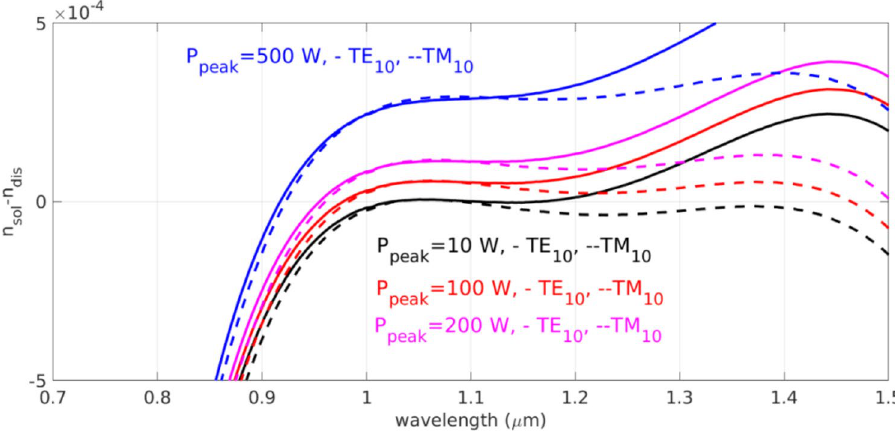
Figure 5. Calculated phase matching condition as the difference between the soliton index and dispersive wave of TE 10 and TM 10 modes in waveguide of 1500 nm width under the peak power of 10 W, 100 W, 200 W and 500 W. The nonlinear refractive index of 10 −14 cm −2 /W is adopted. The phase matching wavelengths for the dispersive waves of TM 10 modes in waveguide of 1500 nm width fall in 1.02 μm and 1.1 μm at peak power of 10 W. At the peak power of 100 W, the dispersive waves are at 0.98 μm and 1.46 μm. At the peak power of 200 W, the dispersive waves are at 0.96 μm and 1.5 μm. For higher power, the phase matching falls outsides the experimentally observable range due to the limit of our spectral